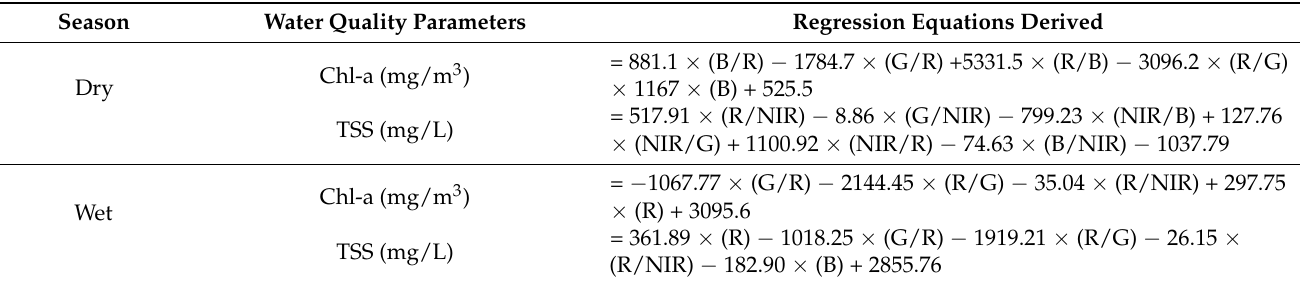
Table 4. Regression analysis between Landsat reflectance and limnological